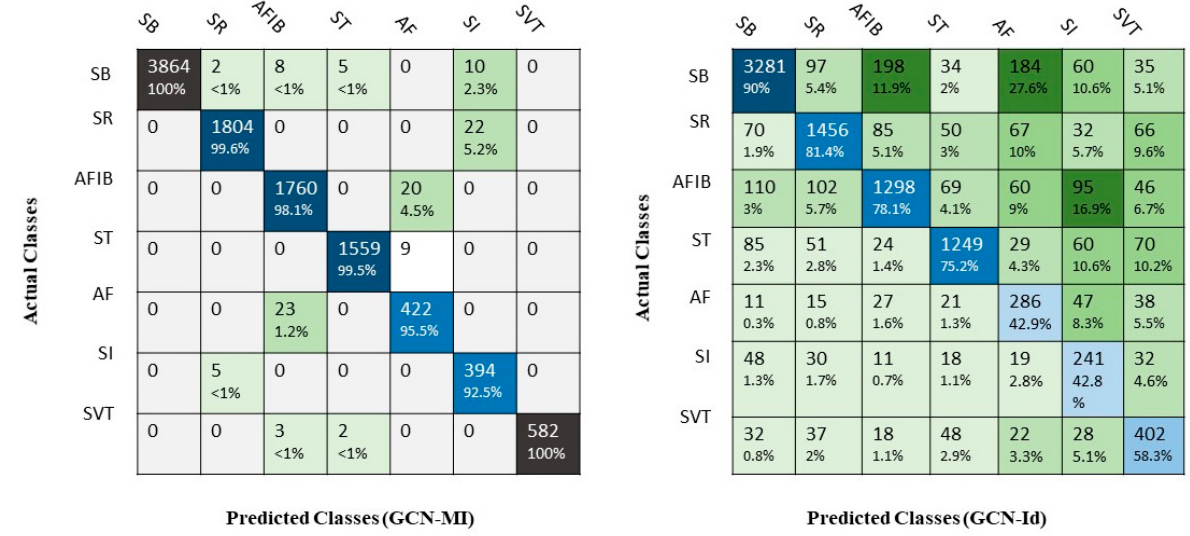
Table 4. The performance values for all records separately for each class using GCN-MI and GCN- Id. Sensitivity Precision Specificity Accuracy